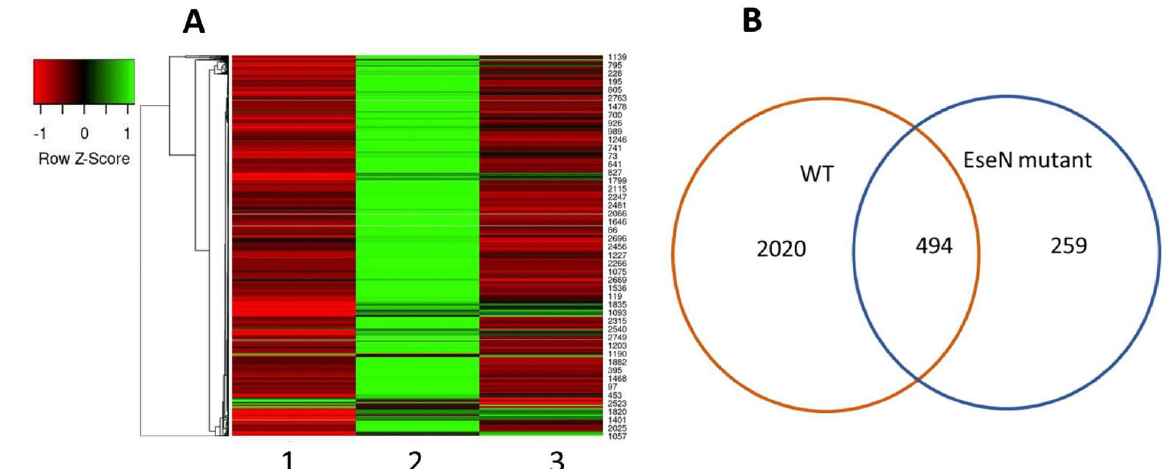
Figure 1. Differentially expressed genes from three independent RNAseq experiments using HKDM infected with WT E. ictaluri (HKDM-WT) as well as an E. ictaluri ΔEseN mutant (HKDM - ΔEseN). ( A ) Cluster analysis of 753 significant differentially expressed genes (by p and q values less than 0.05) in HKDM- ∆EseN compared to HKDM -WT. 1. Uninfected HKDM, 2. HKDM-WT, 3. HKDM- ∆EseN. ( B ) Comparative transcriptomic analysis of genes that were significantly differentially ex- pressed in HKDM-WT compared to uninfected HKDM (WT), and HKDM- ∆EseN compared to HKDM-WT .